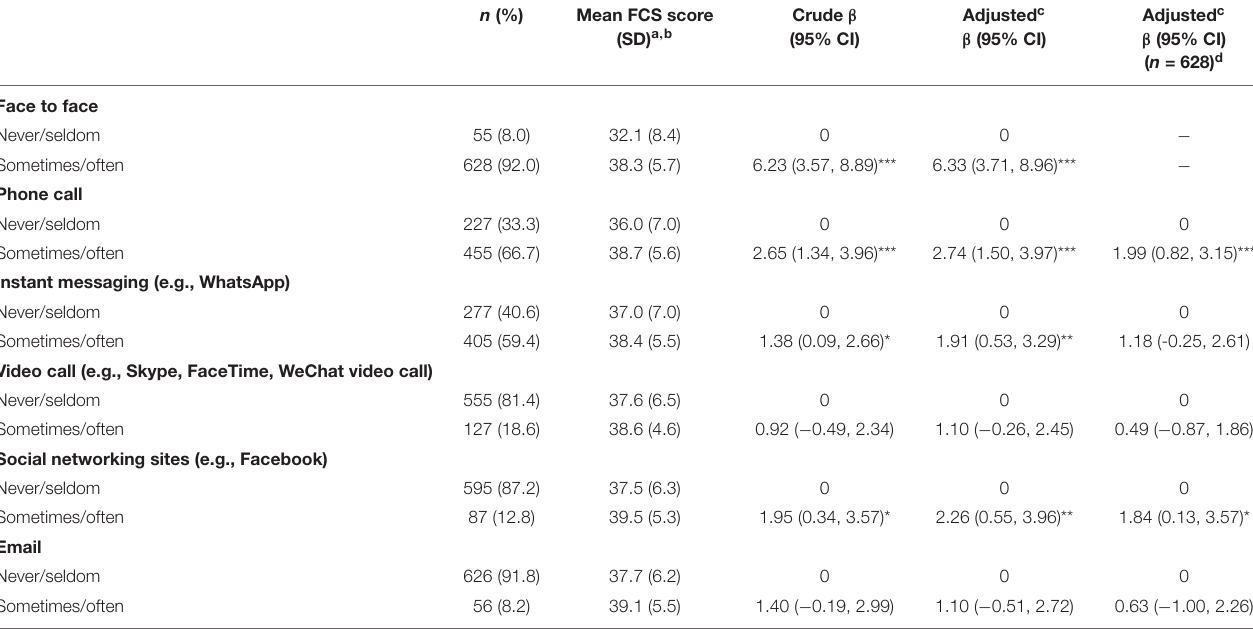
TABLE 6 | Associations of communication method with Family Communication Scale score in the population-based sample ( N =